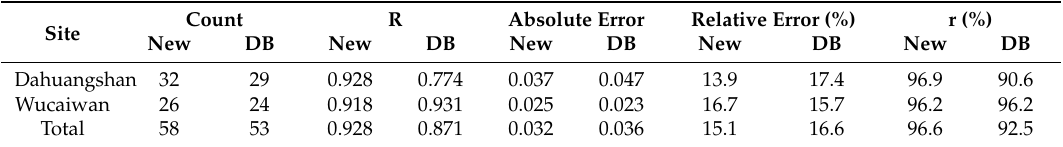
Table 6. Comparisons of retrieval accuracy between the new algorithm (New) and Terra-MODIS C6 DB product (DB).